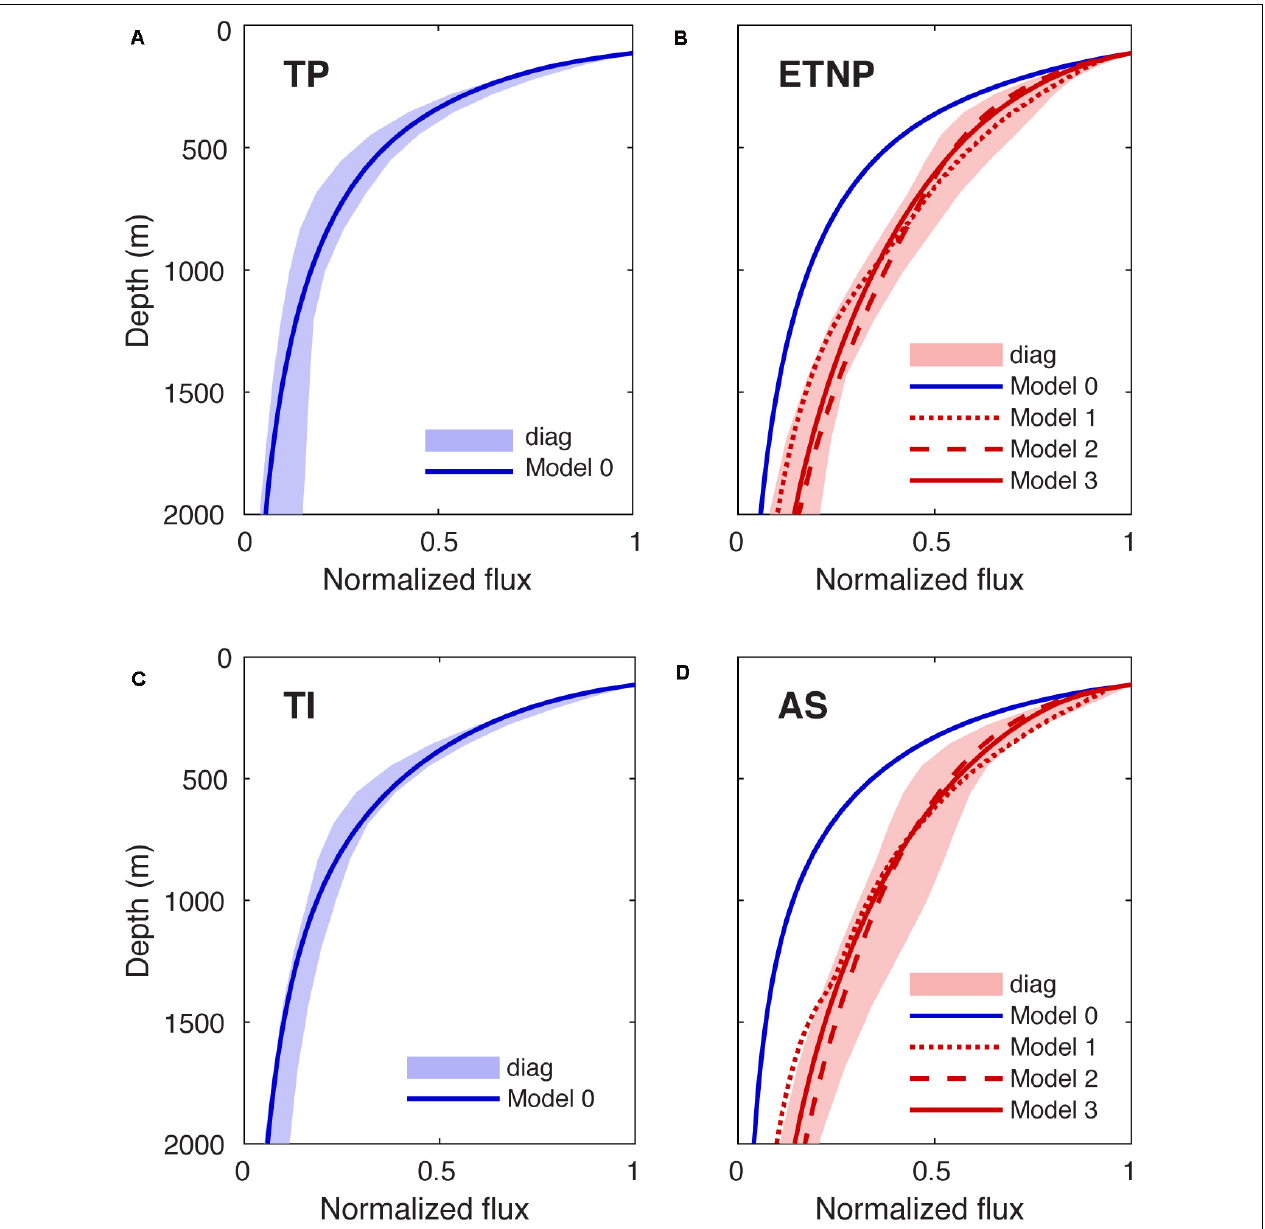
FIGURE 3 | Particle flux profiles predicted by a mechanistic size-resolved model. (A) Normalized particle flux predicted by the default Model 0 configuration (blue line) in the TP region, compared to the uncertainty envelope of the reconstructed flux (blue shading, repeated from Figure 2C ). (B) Predicted particle fluxes in the ETNP region from Model 0 (blue line) and Models 1–3 (red lines), which simulate different O 2 effects on particle flux attenuation, compared to the reconstructed profile (red shading). (C,D) Same as (A,B) but for the TI and AS regions,